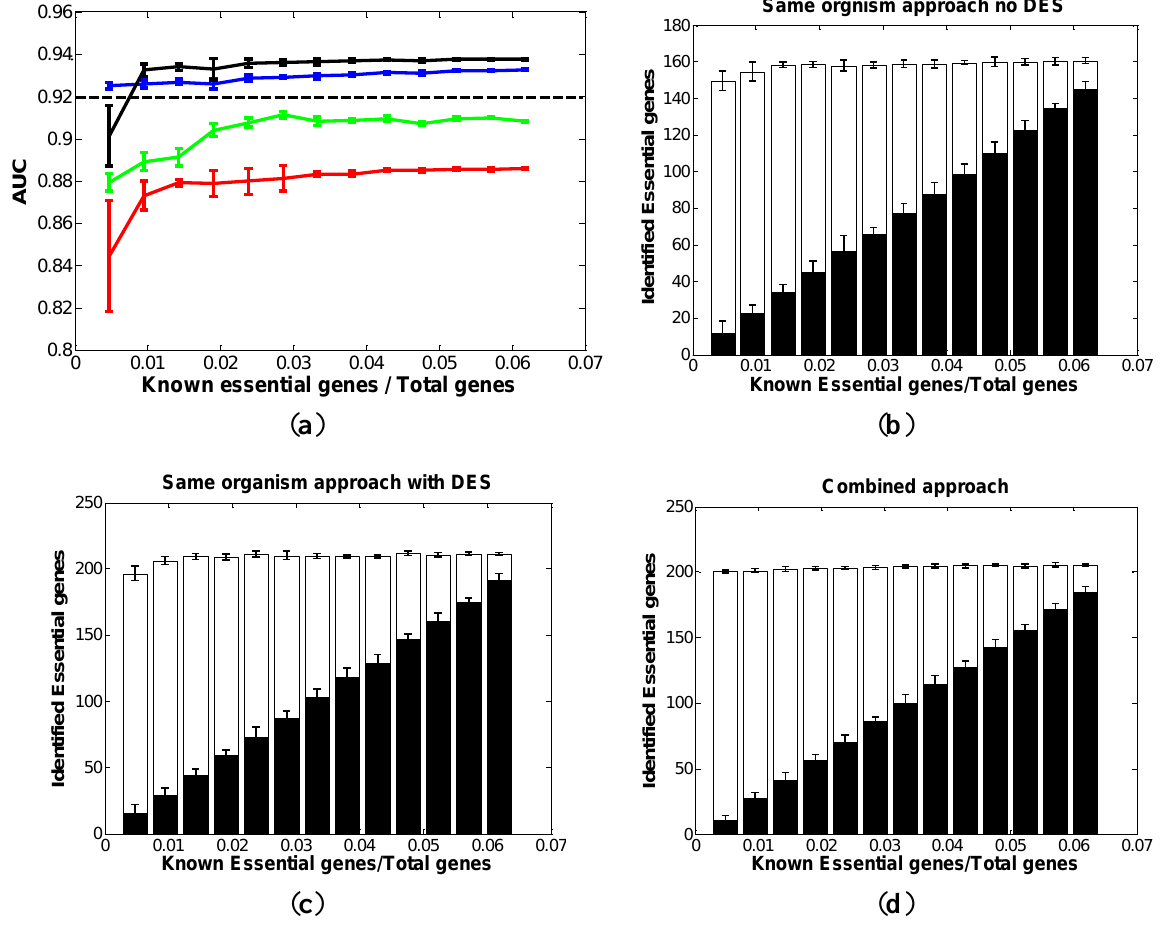
Figure 1. Comparison of three approaches in EC . ( a ) The distribution of AUC along with the different sizes of known essential genes in EC : red curve: same-organism approach “with no-DES”; black curve: same-organism approach “with DES”; blue curve: combined approach; green curve: the DES feature only dashed line: cross-organism approach. The bar chart of the correctly classified essential genes among the top 400 predictions with respect to the different sizes of known essential genes in EC using ( b ) “no-DES” model; ( c ) “with-DES” model; and ( d ) combined model. The black bar shows the correctly classified essential genes in the “gold standard”